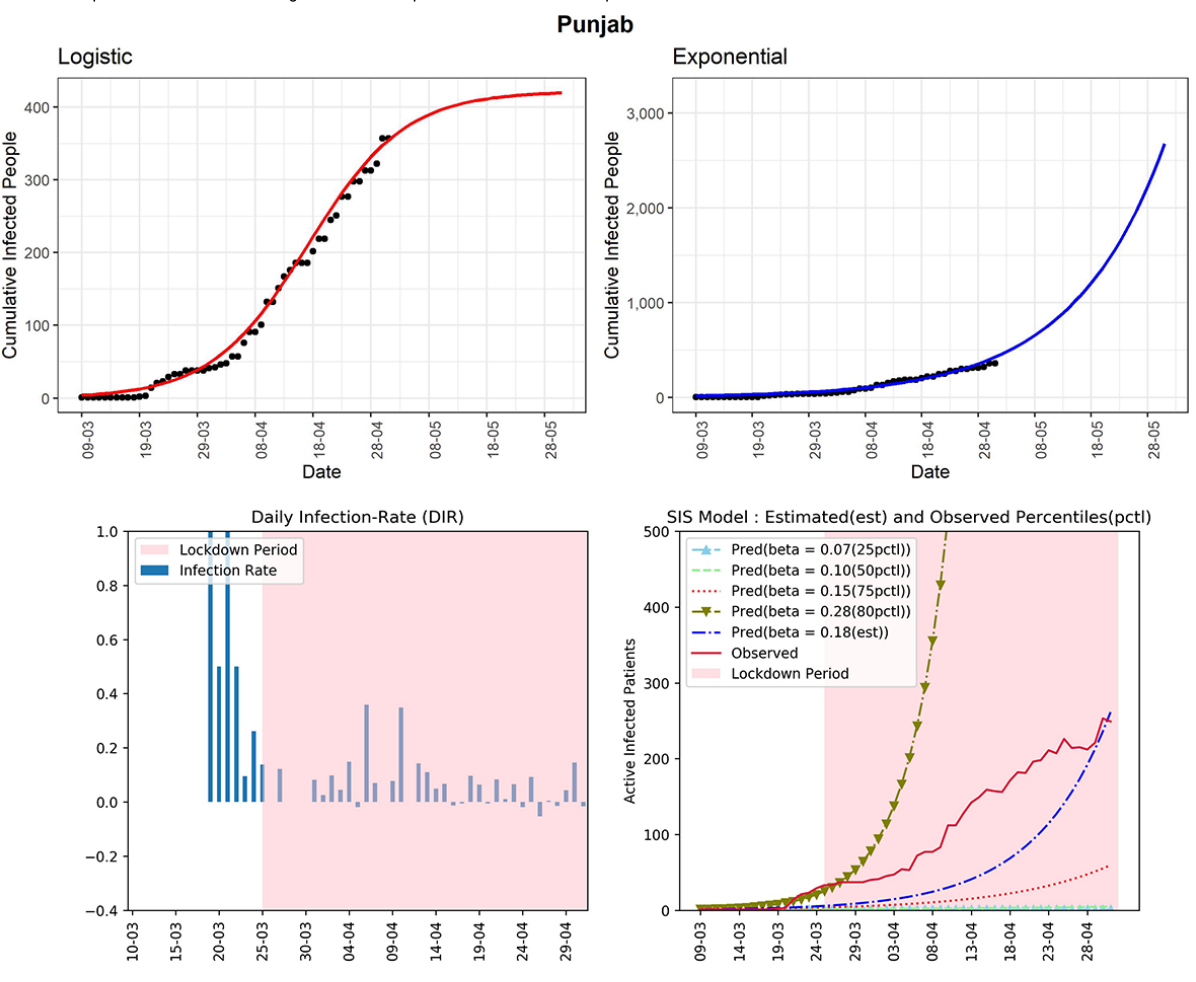
Figure 18. Graphs for the state of Punjab. SIS: